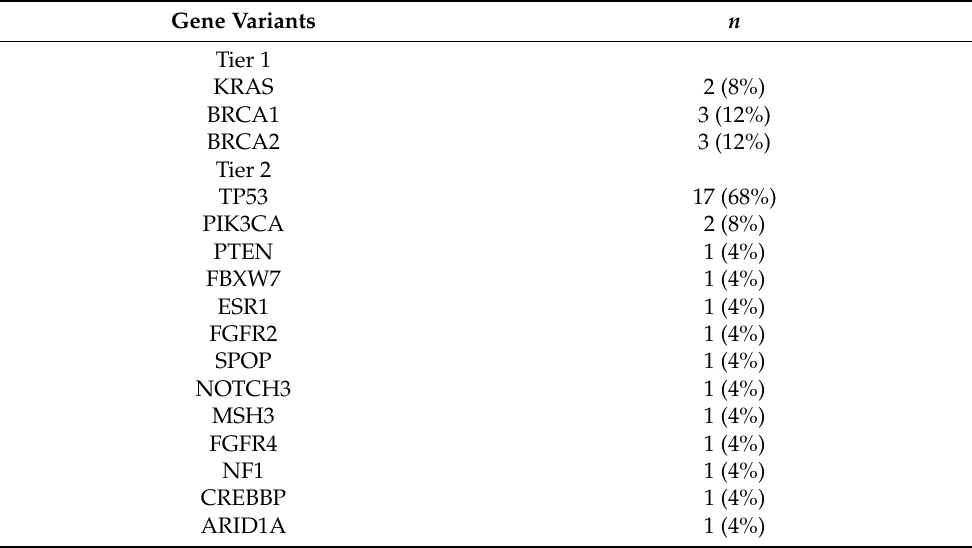
Table 3. Frequency of SNV/Indel variants in Tiers 1 and 2 found in NGS results.